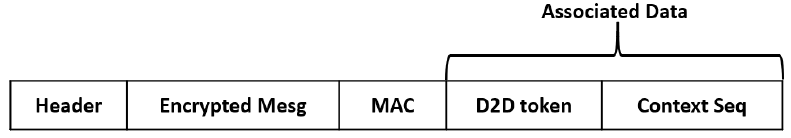
Figure 4. Data format for data communication. Table 2. A list of lightweight authenticated encryption with associated data (AEAD) ciphers (National Institute of Standards and Technology (NIST) lightweight cryptography standardization (Round